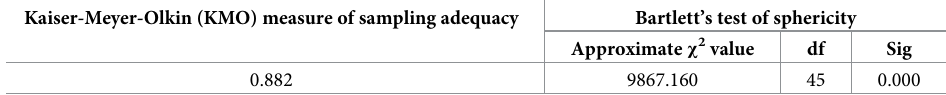
Table 6. KMO and Bartlett’s